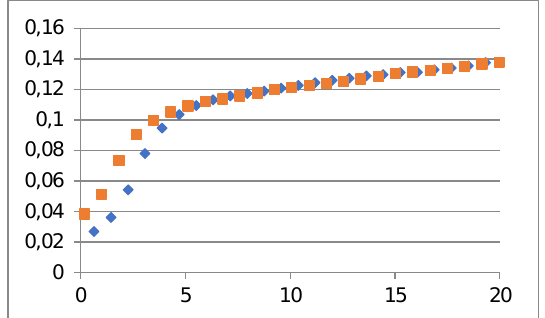
Fig. 7 Re=9000; Dependence of Velocity on the distance from active surface, which is on the position